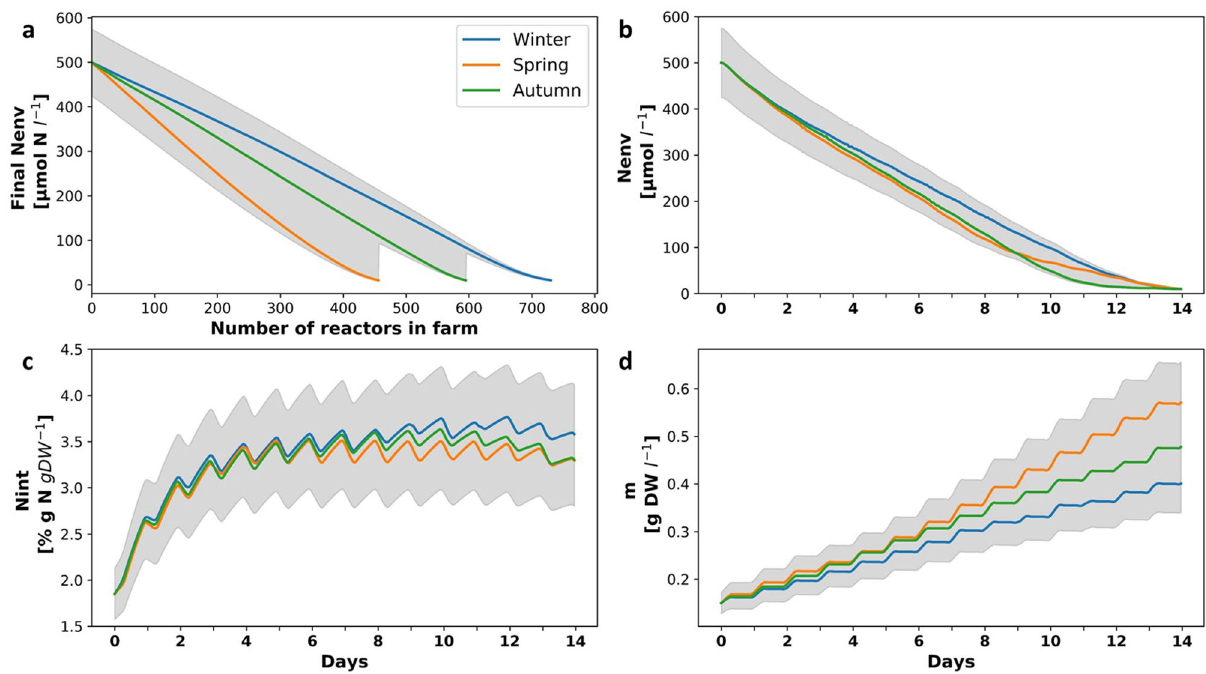
Fig. 4 N env , N int and m dynamics in a seaweed farm in different seasons, along a 14 days cultivation period. a Final N env concentration ( μ M-N) after 14 days of cultivation as a function of the number of reactors in different seasons (Winter in blue, Spring in orange and Autumn in green) . b – d N env , N int and m dynamics along 14 days ’ cultivation periods in different seasons, for the last reactor in a farm of 731 reactors. Shaded region represents a 15% calibration